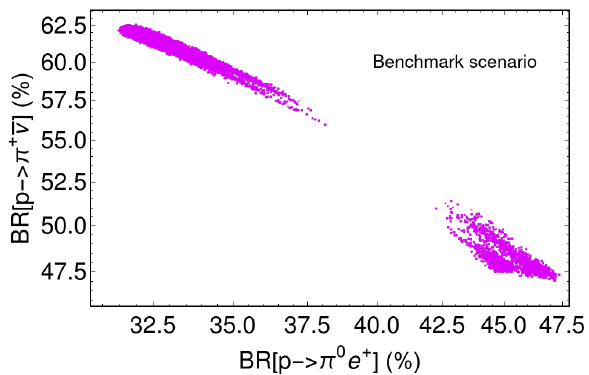
Figure 7 . Proton decay branching ratios of the two most dominating channels in the benchmark scenario resulting from MCMC analysis.